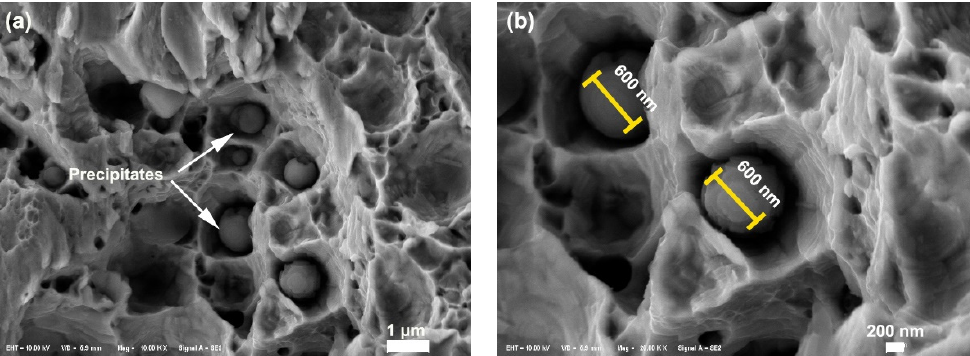
Figure 5. ( a ) Fractography of AM-Inconel 625 after tensile test at room temperature; ( b ) High magnification of the fracture surface in ( a ).